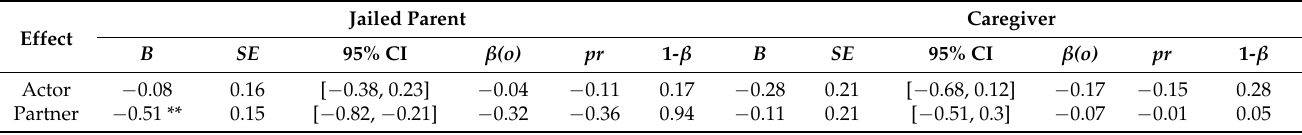
Table 3. APIM analyses of jailed parent and caregiver externalizing behaviors and coparenting alliance.